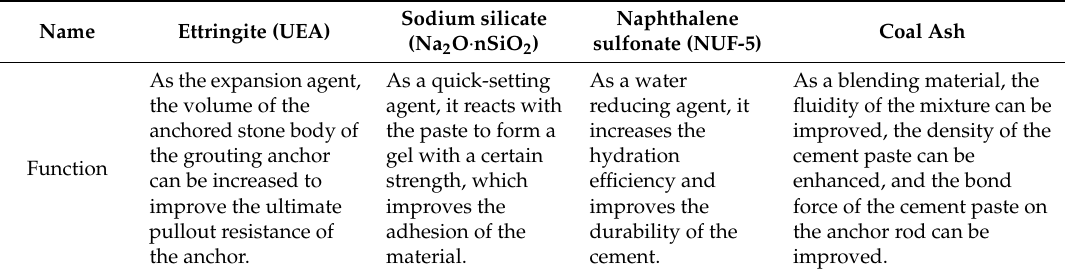
Table 2. Admixture performance.